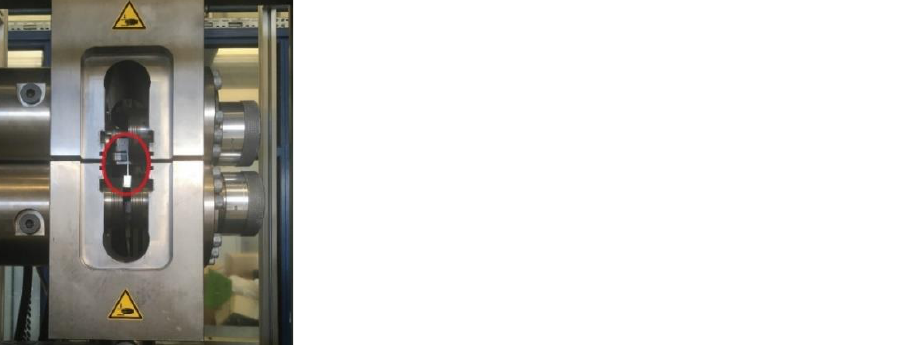
Figure 3. CoCr – 304 specimen fixed using the ZwickRoell system during the tensile tests; the red circle marks the specimen.